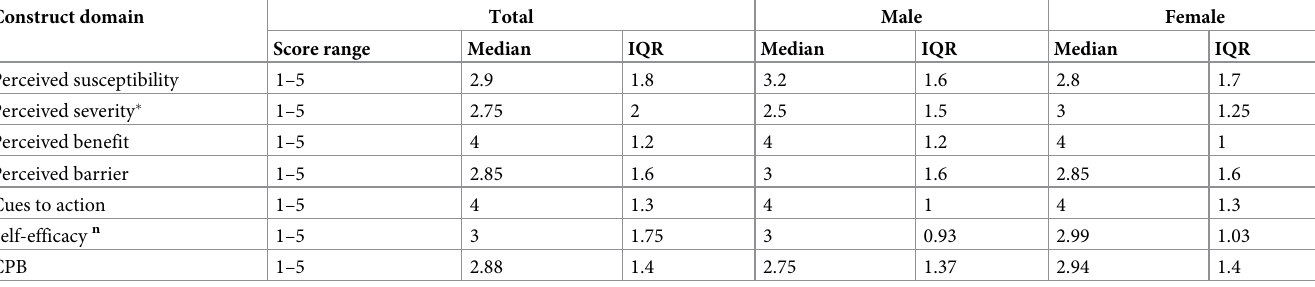
Table 3. Descriptive summary results of Health Belief Model variables.